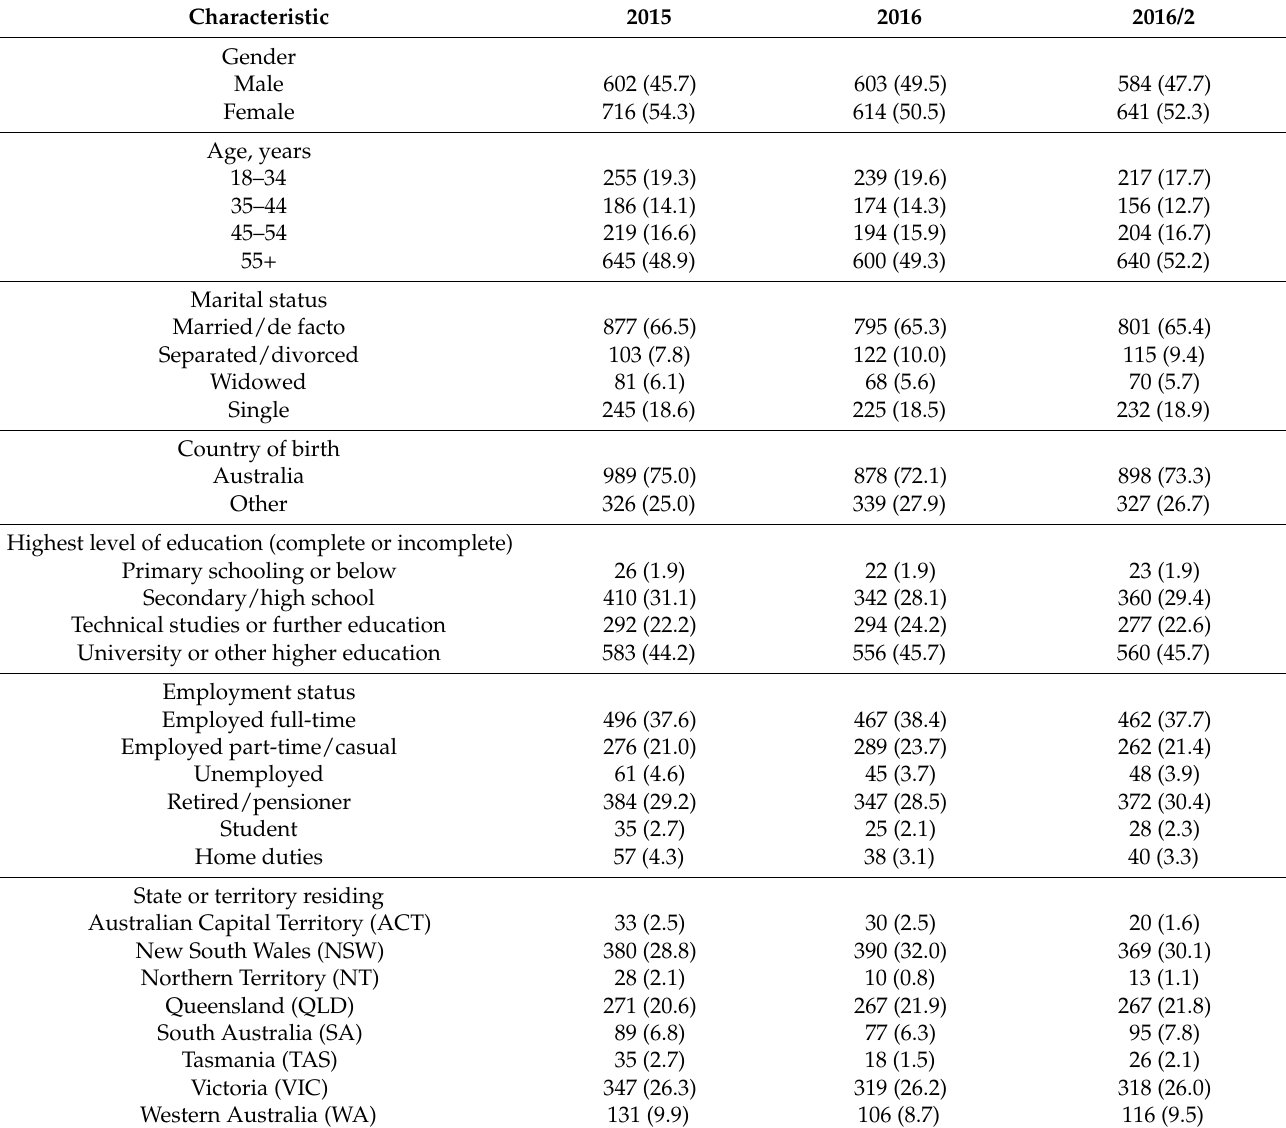
Table 2. Participant demographic